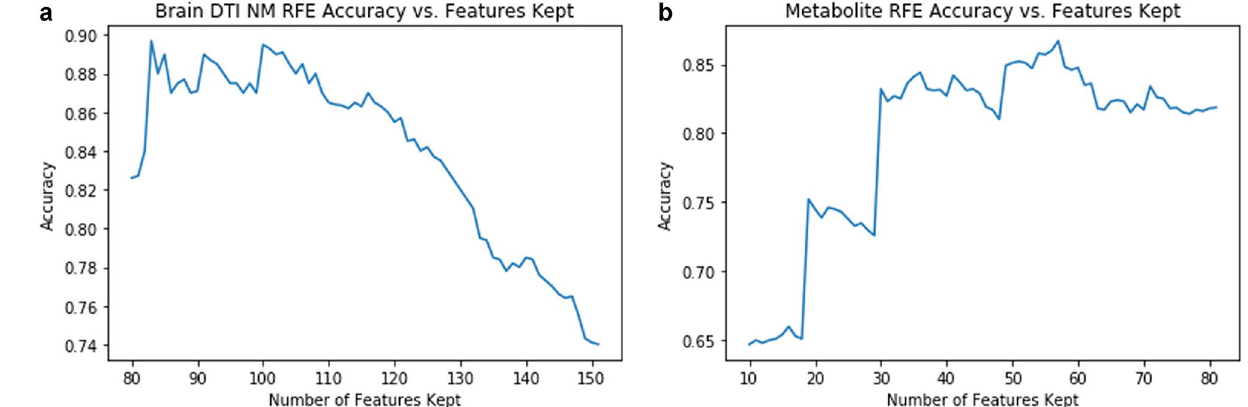
Figure 2. Recursive feature elimination graph of brain network metrics ( A ) and metabolites ( B ). A linear model is first developed incorporating all features and iteratively, the features with the lowest weight are removed. These graphs demonstrate the relationship between model accuracy and the number of features kept.